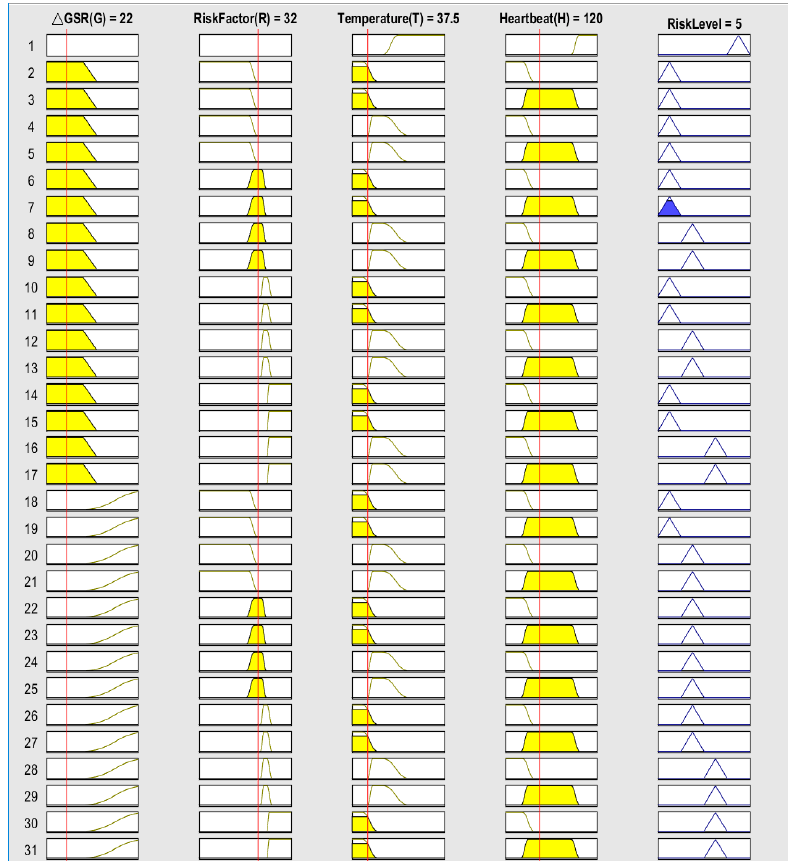
Figure 10. The risk level of heat stroke corresponded to safe status.